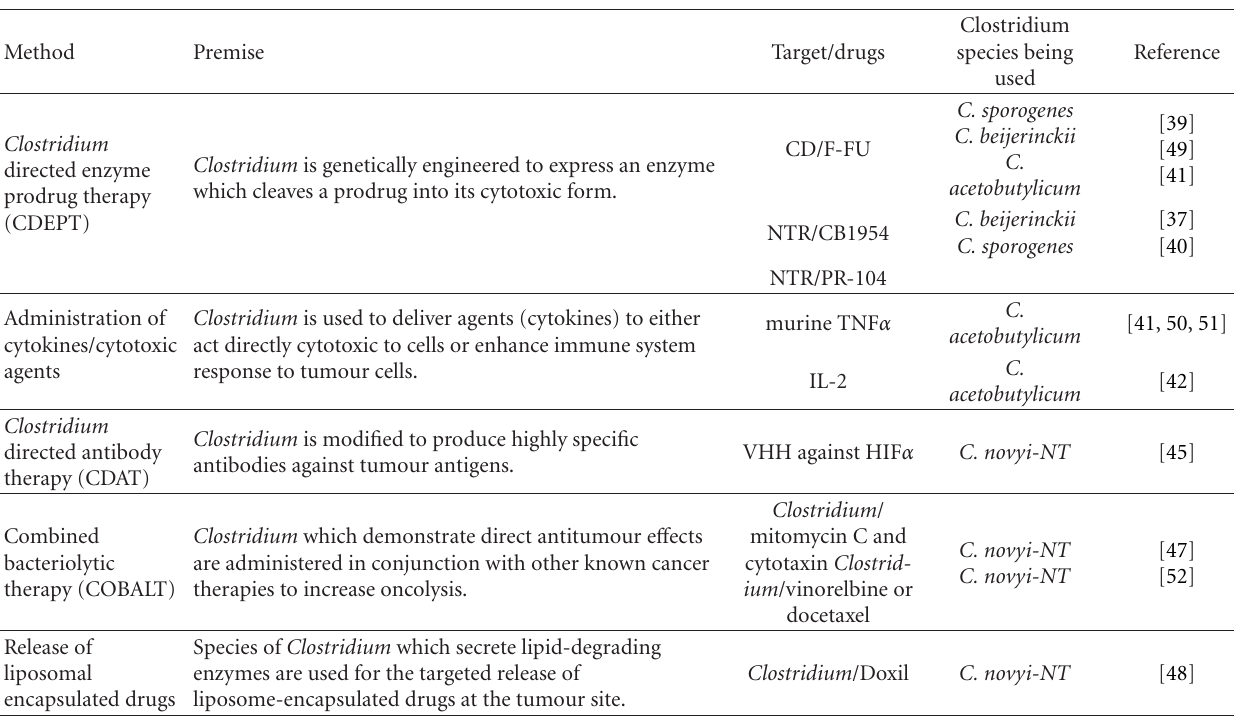
Table 1: Summary of current methods being researched in Clostridium -based cancer